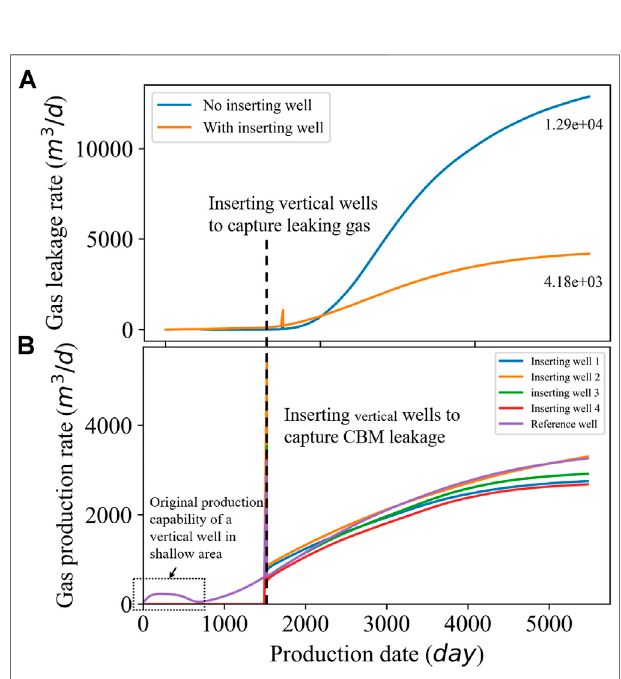
FIGURE 13 | Results of inserting well simulation: (A) gas leakage rate and (B) gas production rate.